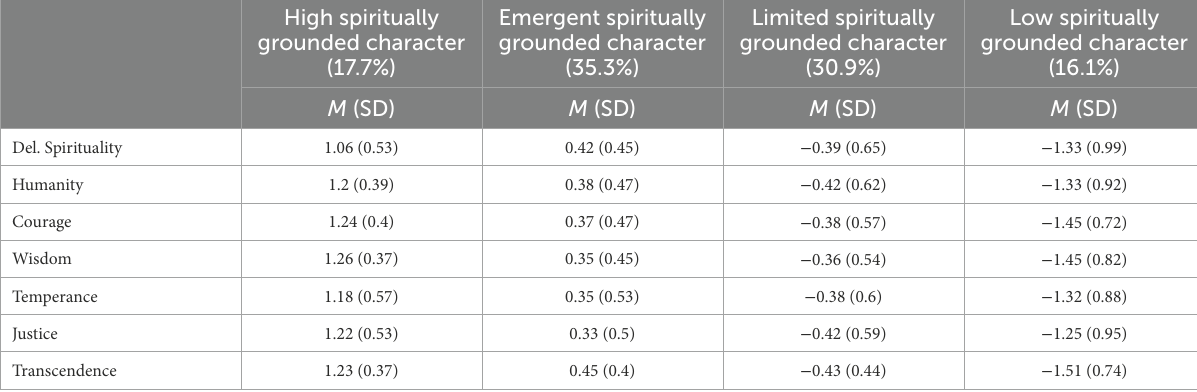
TABLE 4 Standardized mean scores and standard deviations of indicator variables in each profile.